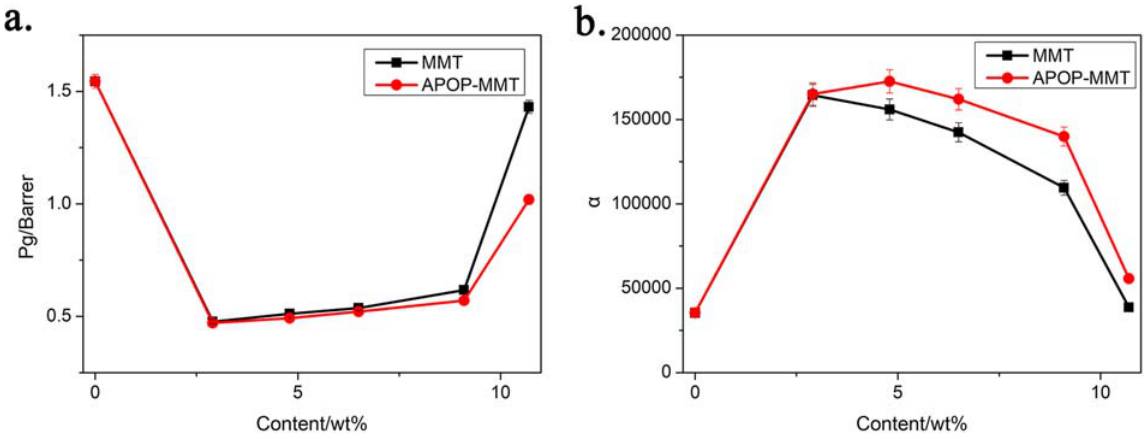
Figure 12: Air permeability coe ffi cient ( a ) and selectivity ( b ) of the MMT/PEBAX® 1074